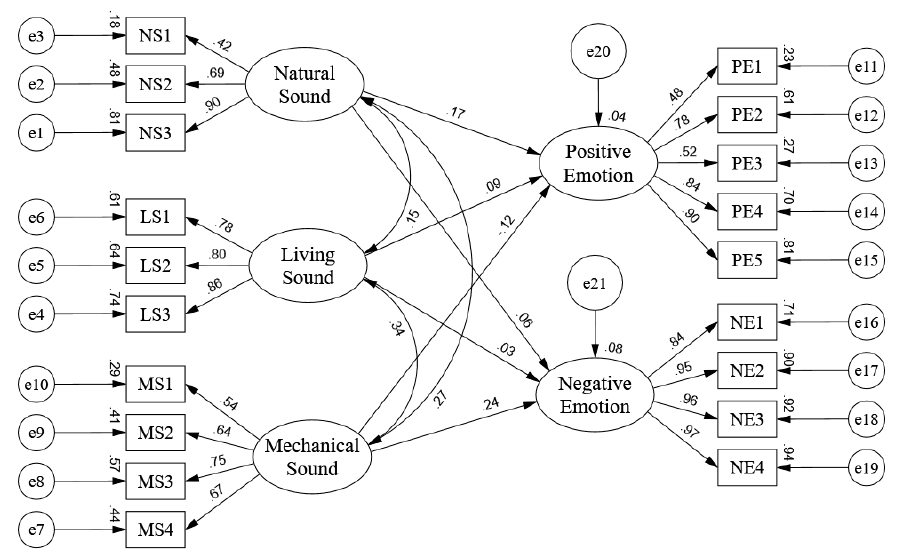
Figure 5. Path diagram of the structural equation model.